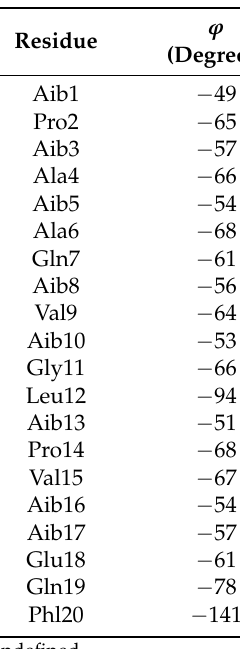
Table 1. Structural features of ALM-18